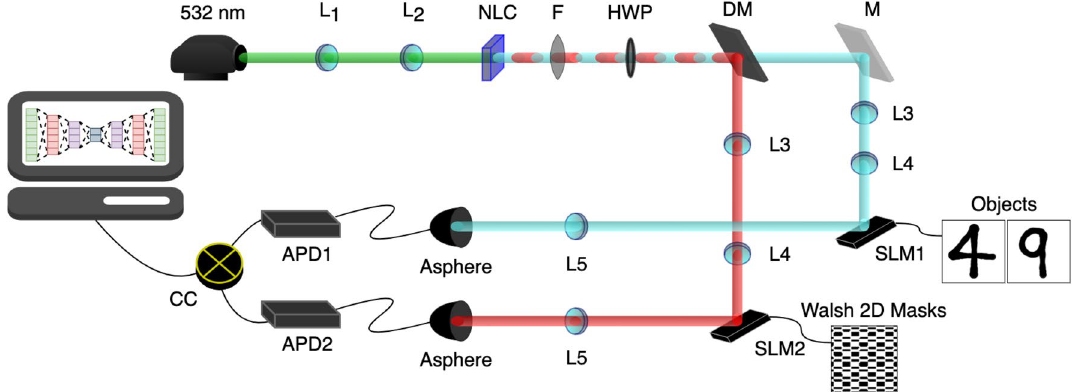
Figure 3. Schematic of the implemented optical setup. Non-degenerate entangled photons are produced at the non-linear crystal (NLC). A dichroic mirror (DM) is used to spatially separate the entangled photons. Each photon impinges on a SLM displaying either the object or patterned mask. The photons are collected by coupling each beam to a multimode fibre connected to an APD, coincidences are then counted to allow for image reconstruction.